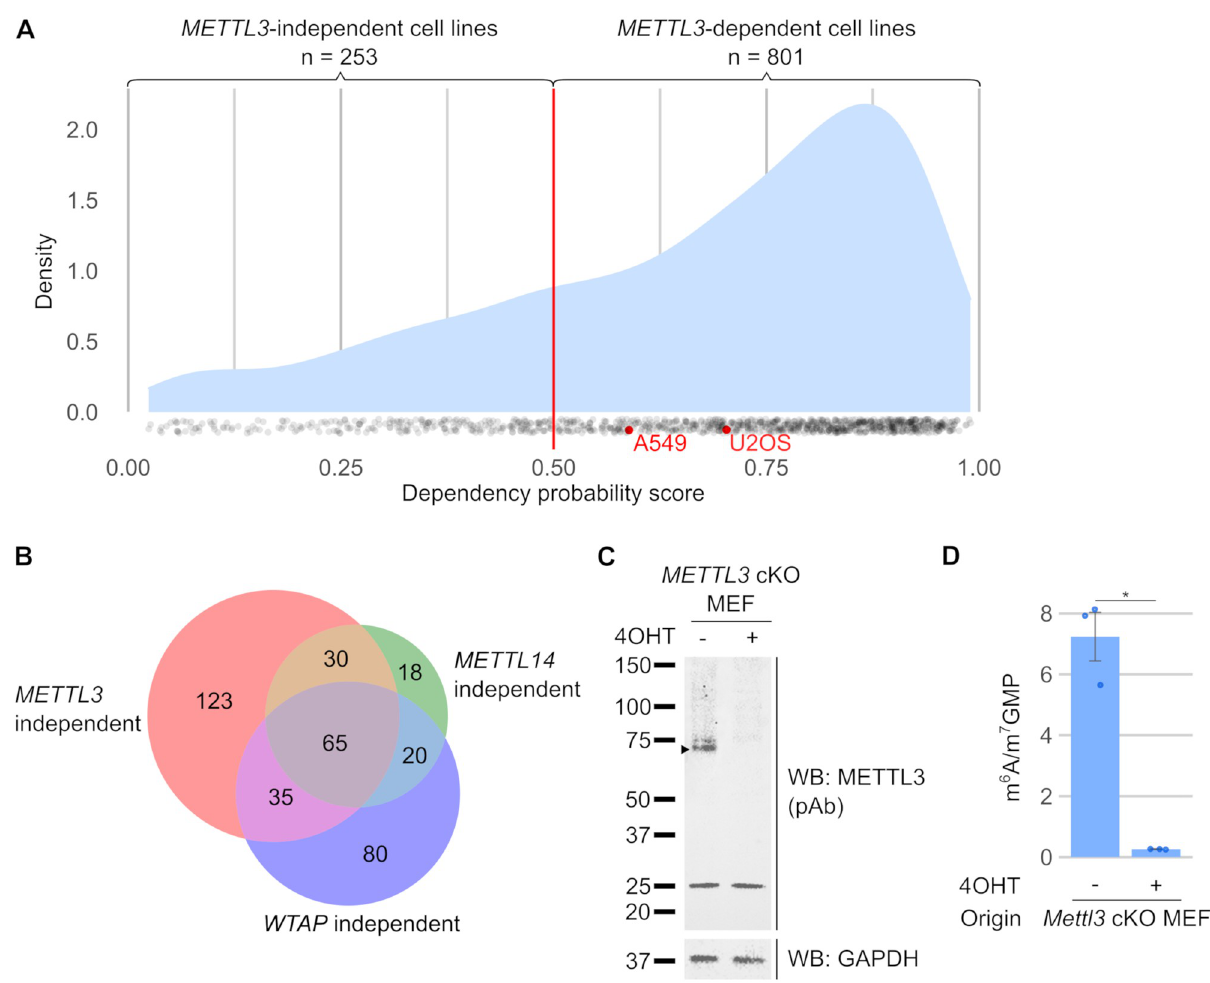
Fig 4. Conditional METTL3 knockouts can be used to study m 6 A when stable METTL3 knockouts are not viable. ( A ) Most cell lines are dependent on METTL3 for growth. Mouse studies previously indicated that Mettl3 is an essential gene for early embryonic survival [5], so we wanted to know which cell lines are dependent on METTL3 . Using the CRISPR gene dependency probability score from the DepMap 21Q4 dataset [43–47], we found that 801 of 1,054 cell lines are dependent on METTL3 (dependency probability score > 0.5). Therefore, most cells lines will not survive after METTL3 knockout. The density plot shows the overall distribution of dependency probability scores, while each individual cell line is represented as a dot. U2OS and A549 cell lines (red), where METTL3 has been previously knocked out, are shown here to be dependent on METTL3 and thus should not be viable after METTL3 knockout. Underlying data for this figure was extracted from the DepMap 21Q4 dataset [47]. ( B ) A small subset of cell lines may be m 6 A independent. Although most cell lines are dependent on METTL3 , a small subset of cell lines can survive despite METTL3 knockout. To identify cell lines that we can confidently consider m 6 A-independent, we obtained a list of cell lines whose survival is also independent of other members of the m 6 A writer complex, METTL3 , METTL14 , and WTAP . This approach suggests that 65 cell lines may be able to proliferate in an m 6 A-independent manner (S4 Table). Underlying data for this figure was extracted from the DepMap 21Q4 dataset [47]. ( C ) Mettl3 conditional knockout MEFs do not express METTL3 protein. To determine the amount of m 6 A in mRNA that can be attributed to Mettl3 , we generated a tamoxifen-inducible Mettl3 conditional knockout MEF cell line. We used WB to validate the loss of METTL3. After 5 days of 4-hydroxytamoxifen treatment (500 nM), we observed loss of the WT METTL3 protein. 30 μ g per lane. ( D ) Mettl3 conditional knockout MEFs show near-complete loss of m 6 A. We measured m 6 A levels in mRNA derived from tamoxifen-inducible Mettl3 conditional knockout MEFs. Eight days after 4OHT treatment (500 nM), the Mettl3 KO MEFs showed 3.6% remaining m 6 A. Hence, m 6 A is almost completely lost after Mettl3 knockout in MEFs. Error bars indicate standard error ( n = 3). � = p -value < 0.5, �� = p -value < 0.01, ��� = p -value < 0.005, n.s. = not significant. Underlying data can be found in S1 Data. m 6 A, N 6 -methyladenosine; MEF, mouse embryonic fibroblast; pAb, polyclonal antibody; WB, western blot; 4OHT,